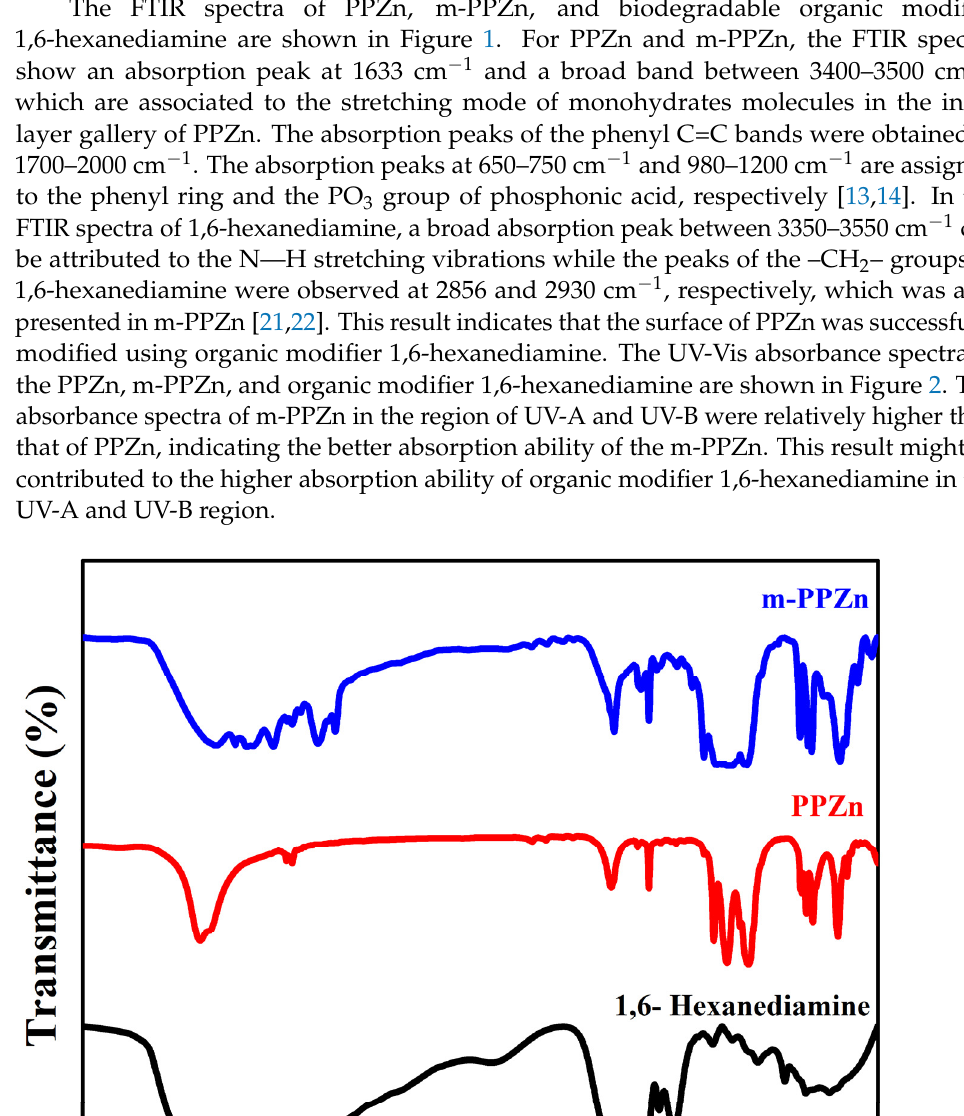
Figure 2. UV-Vis absorbance spectra of the PPZn, 1,6-hexanediamine and m-PPZn. The green lines in this figure illustrate the UV-A, UV-B, and UV-C regions. The WAXD profiles of the m-PPZn, g-PBCT, and g-PBCT/m-PPZn composites are shown in Figure 3. According to previous investigation [12], three strong diffraction peaks at 2 θ = 6.34°, 12.49°, and 18.68° were obtained for the PPZn, which characterize to the